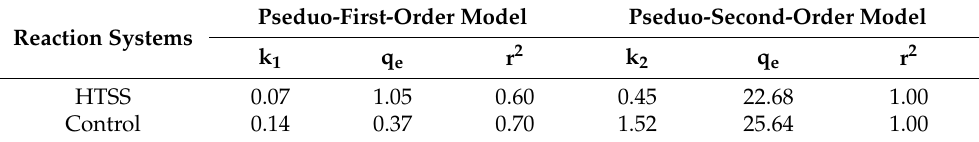
Table 3. Fitting results of adsorption